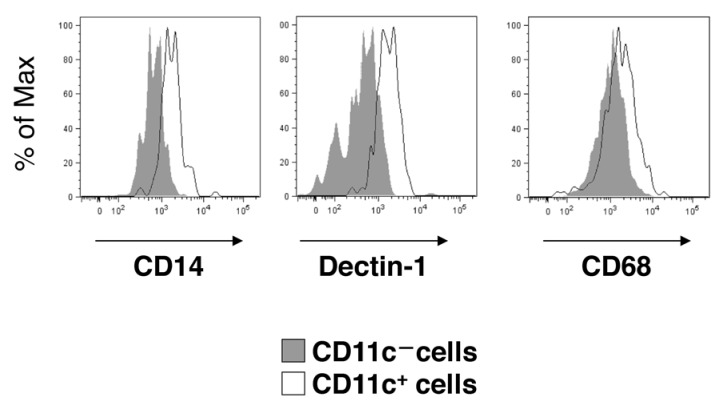
Flow-cytometry analysis of microglia in SIRPα cKO mice.Cells isolated from the spinal cord of SIRPα cKO mice at 25–28 wks of age were stained for CD45, CD11b and CD11c, as well as for CD14, Dectin-1, or CD68. CD11b+/CD45dim/lo cells were gated, and the expression of CD14, Dectin-1, or CD68 on CD11c-positive and -negative microglia was analysed. Expression profiles for each molecule in CD11b+/CD45dim/lo microglia are shown. Filled and open traces indicate CD11c– and CD11c+ cells, respectively. Similar results were obtained from another independent experiment using female animals.